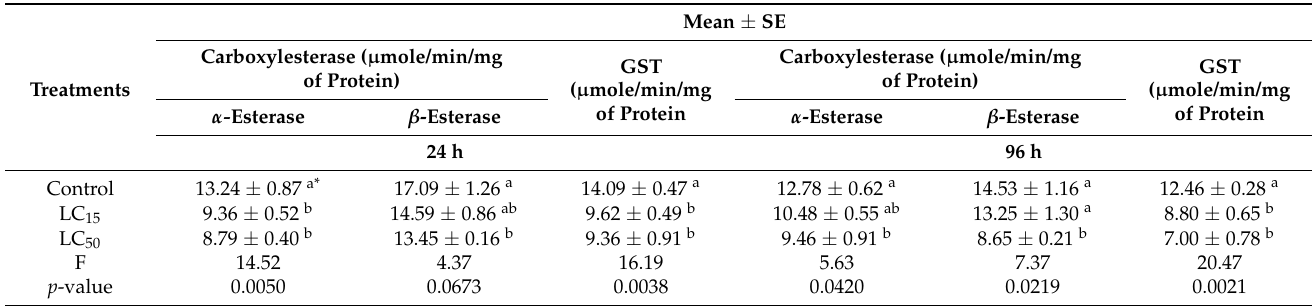
GST ( µ mole/min/mg of Protein α - Esterase β -Esterase α -Esterase β -Esterase